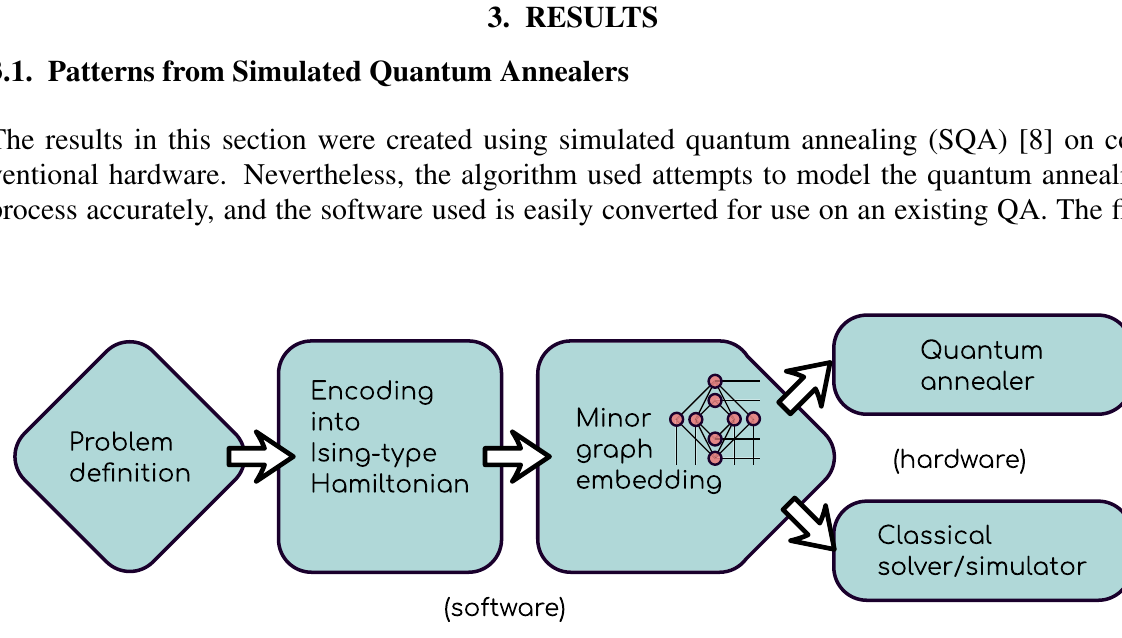
Figure 2: A diagram of showing the operation stack of a quantum annealer (based on